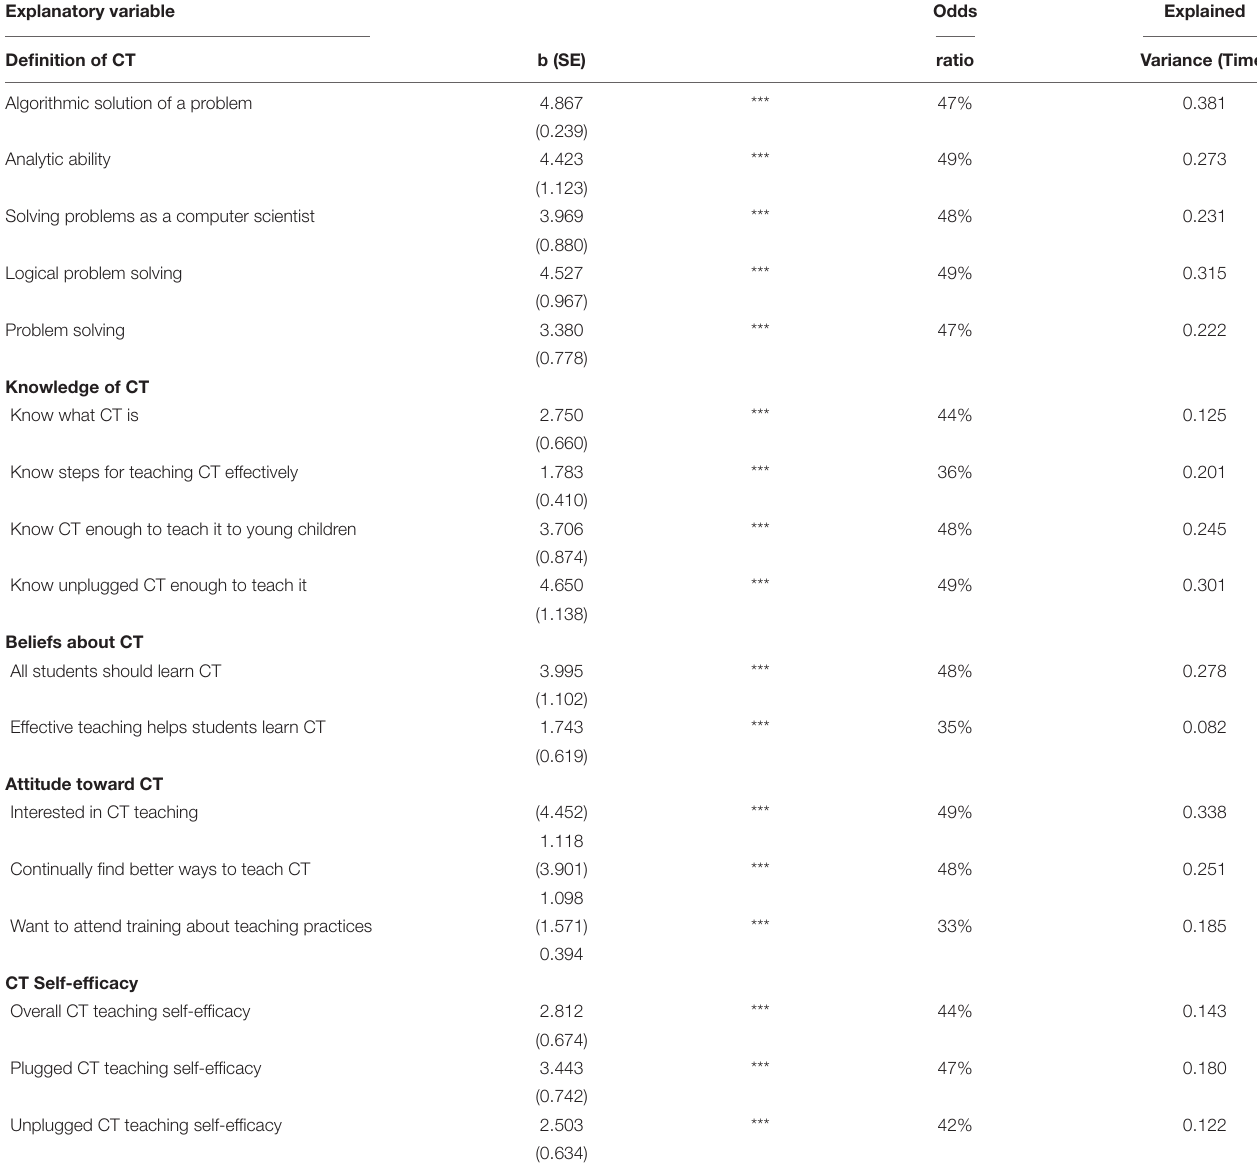
TABLE 4 | Multilevel cross-classification differences